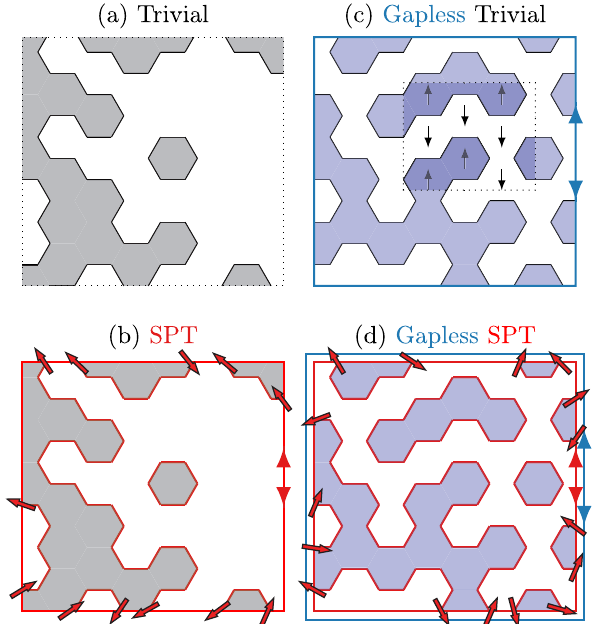
FIG. 1. Representative states of each order in the 2 d example. (a) Trivial: Paramagnetic spins on a triangular lattice with fluctuating domain walls. (b) SPT: Decorating the domain walls, giving a SPT with a c ¼ 1 edge mode. (c) Gapless trivial: Tuning the domain walls to criticality by restricting them to fully packed loop configurations (defined below), closing the gap and giving a c ¼ 1 edge mode. (d) Doing both yields a gapless SPT with c ¼ 1 þ 1 ¼ 2 edge